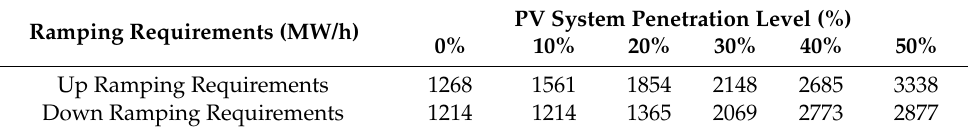
Figure 14. Duration curve of the net load ramping requirements at various PV penetration levels to the grid in Riyadh, 2017. Table 3. Ramping requirements for the grid’s conventional generation system at various PV penetra- tion levels to the grid in Riyadh,